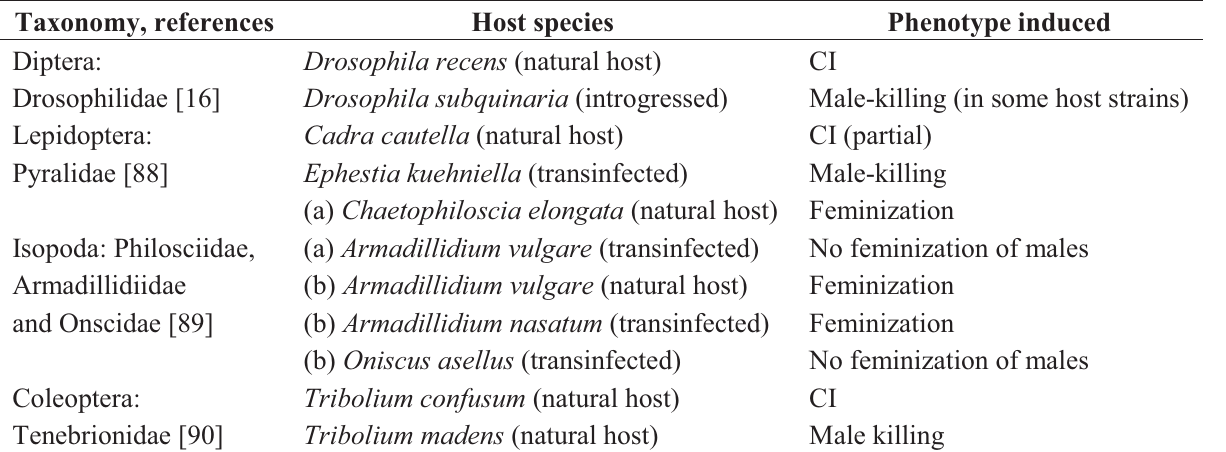
Table 3. Wolbachia strains known to cause different phenotypes or effects in different hosts. Taxonomy,